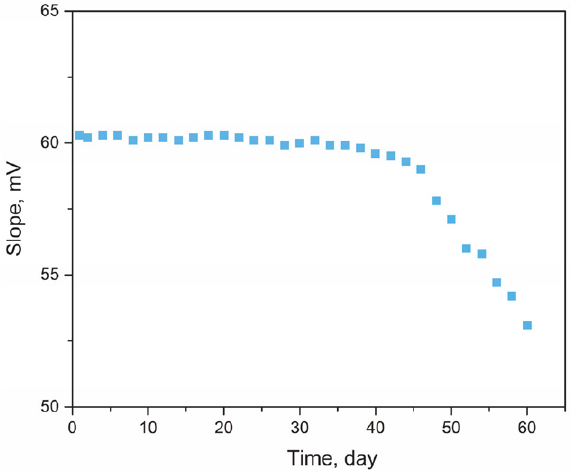
Figure 6. Reproducibility of the DOP-selective microsensor (slope values against